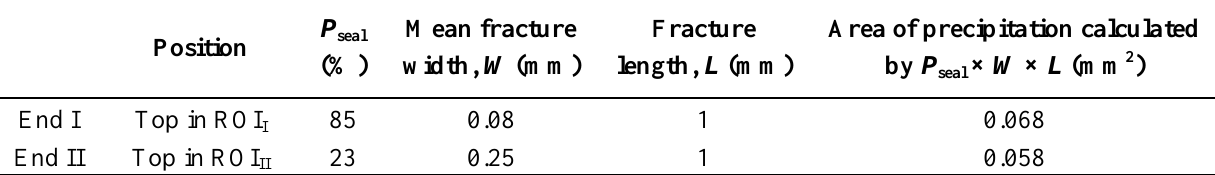
Table 3. Maximum amount of precipitation on macro fracture at 49 days for each end.